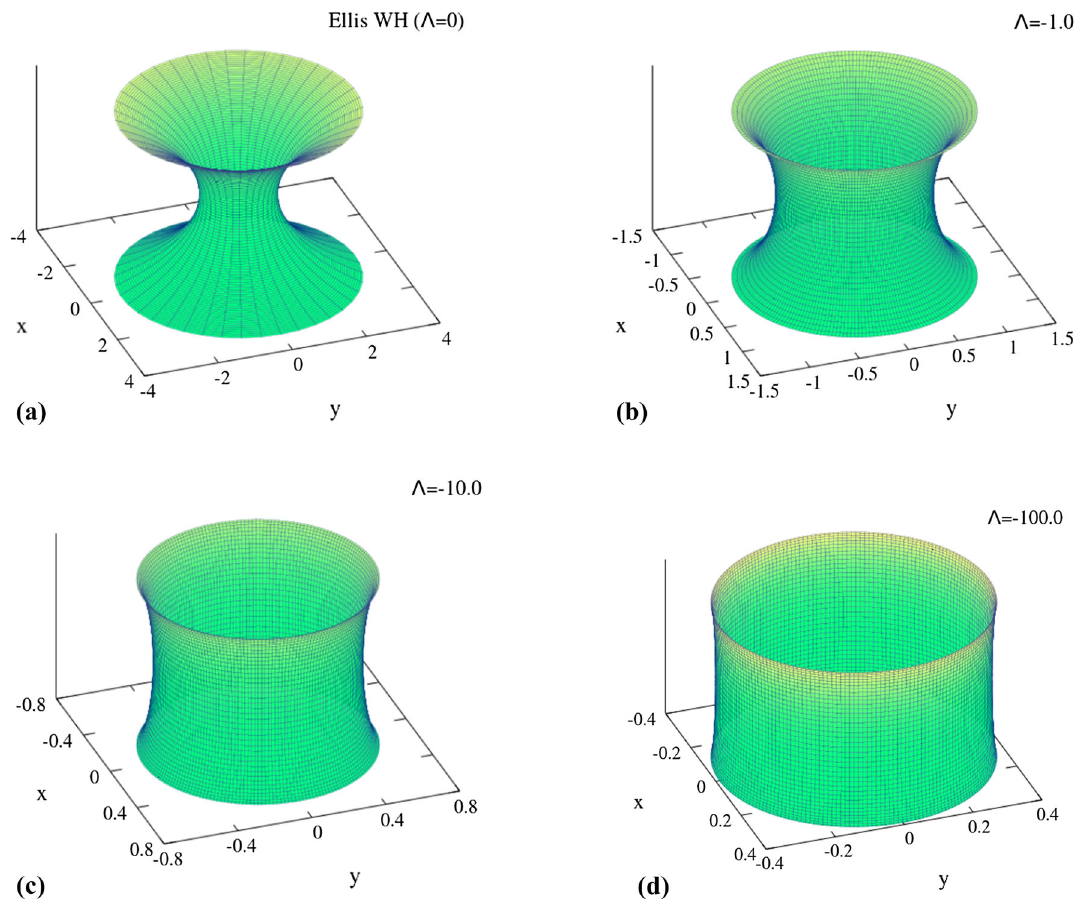
Fig. 3 Isometric embeddings of wormhole solutions for several values of (cid:3) : a (cid:3) = 0 . 0; b (cid:3) = − 1 . 0; c (cid:3) = − 10 . 0; d (cid:3) = − 100 .